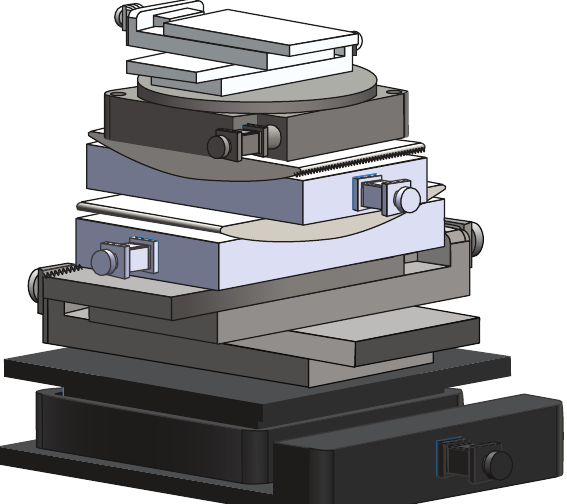
Figure 2: Structure of multidimensional high-precision translation and rotation equipment.